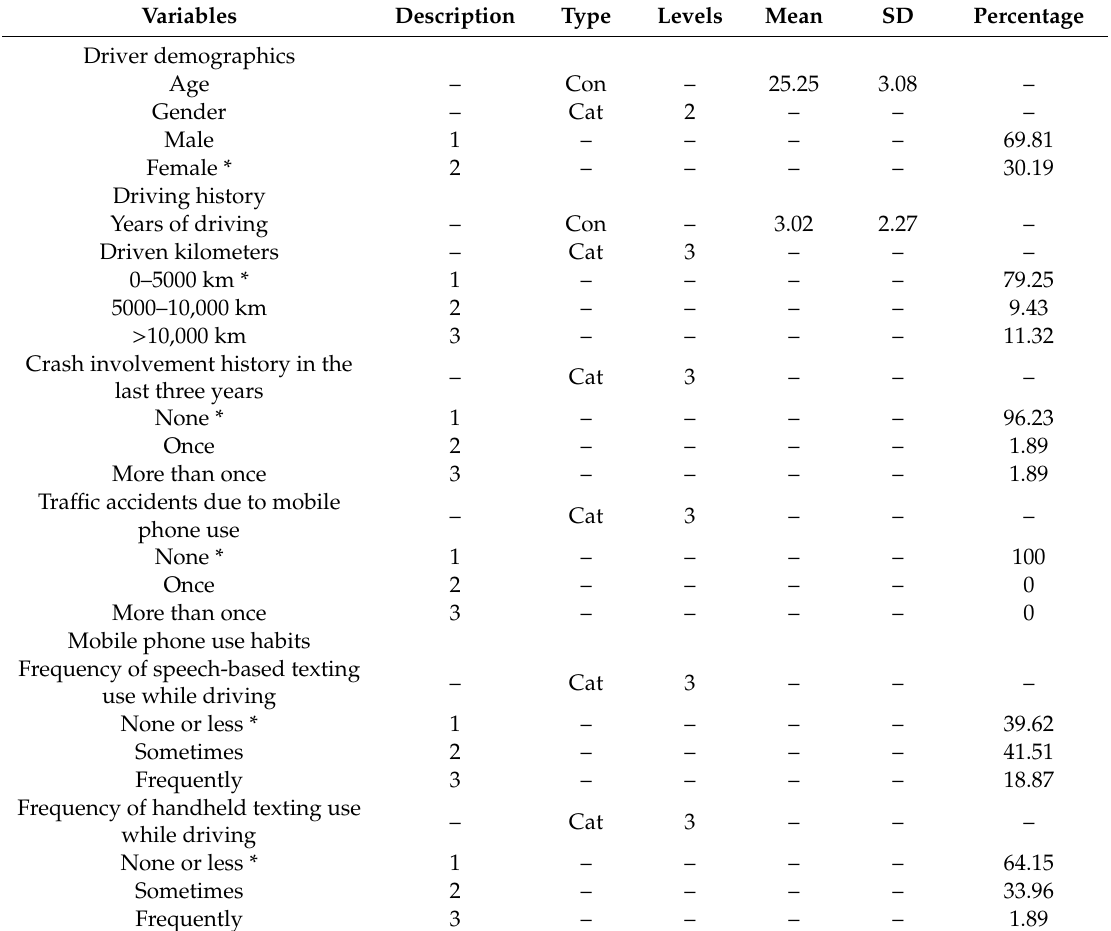
Figure 1. The driving simulator. Table 1. Descriptive statistics of the participants obtained from the questionnaire.